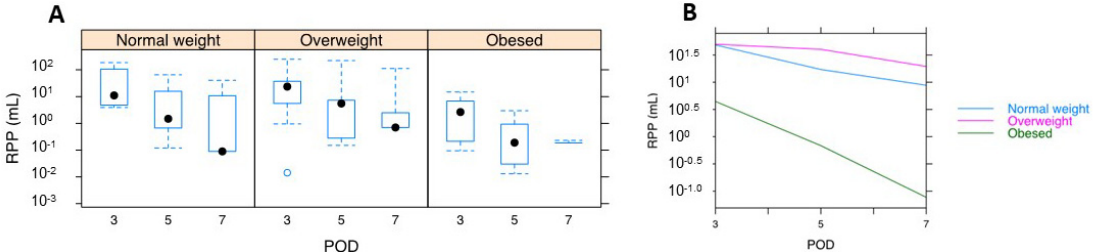
Figure 4. Patient RPP volumes are plotted as a function of stratified BMIs separately (( A ): normal, overweight, obese) and combined ( B ).